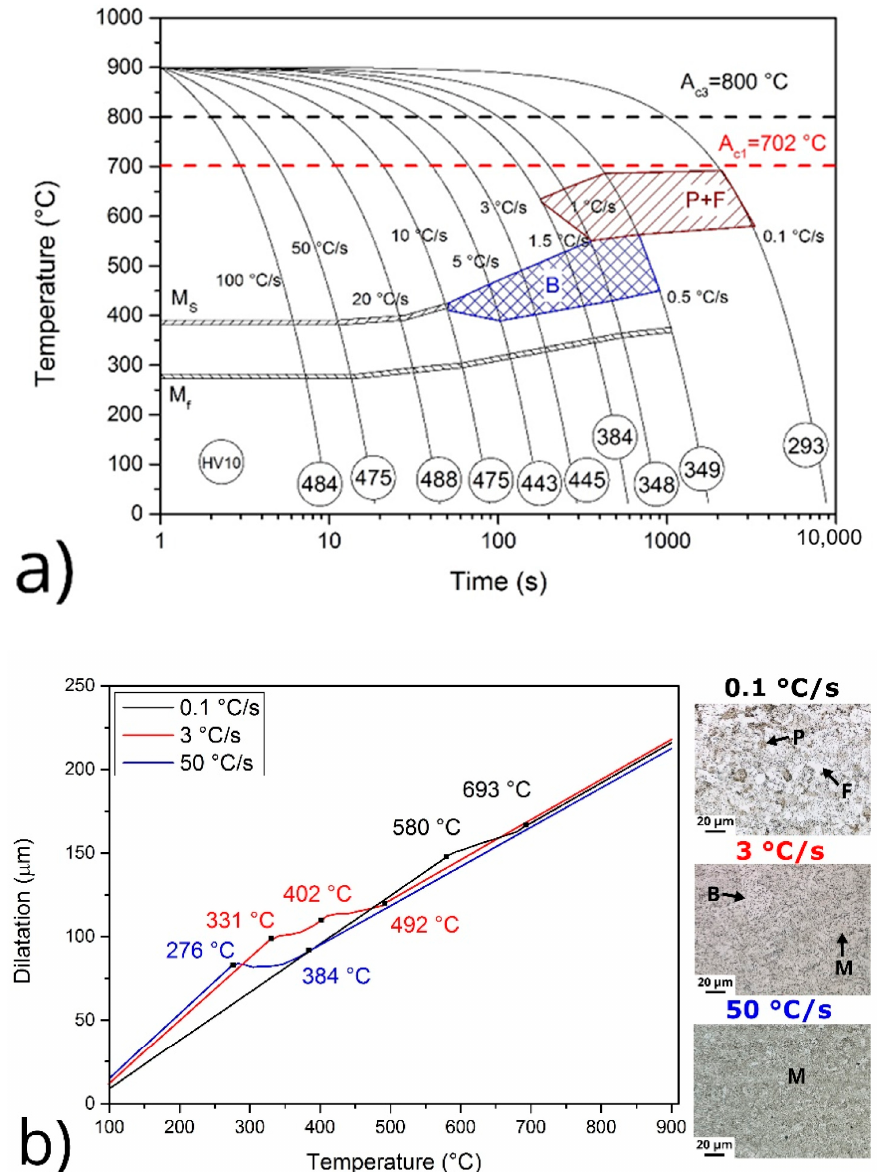
Figure 5. ( a ) Continuous cooling transformation diagram for steel V–Nb with HV10 hardness measurement for each cooling rate. The shaded region presents the possible variation of Nb and Ti–Nb steel. ( b ) Dilatometric curves for cooling rates 0.1, 3 and 50 ◦ C/s with representative microstructure. Marks “F”, “P”, “B” and “M” represent ferrite, pearlite, bainite and martensite,